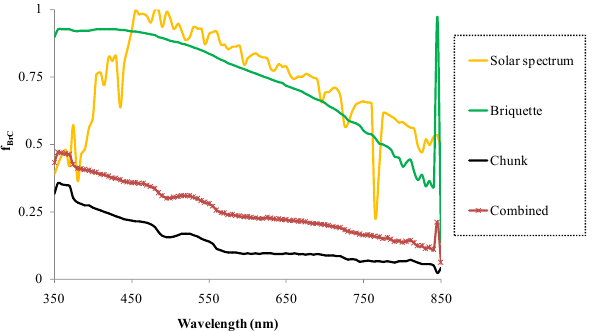
Figure 6. Fraction of light absorption by BrC in total absorption by BrC + BC from residential coal burning. The fraction is expressed as f BrC (λ) and was calculated in accordance with the method de- scribed in the Supplement. The yellow line is the clear-sky air mass 1 global horizontal solar spectrum at the earth’s surface in relative unit (Levinson et al.,